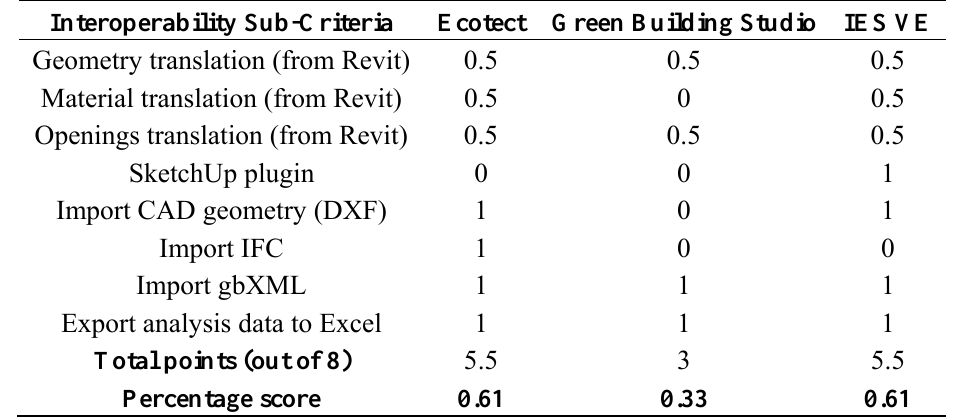
Table A7. Re-evaluation: interoperability criterion calculations for the top three BEM tools.